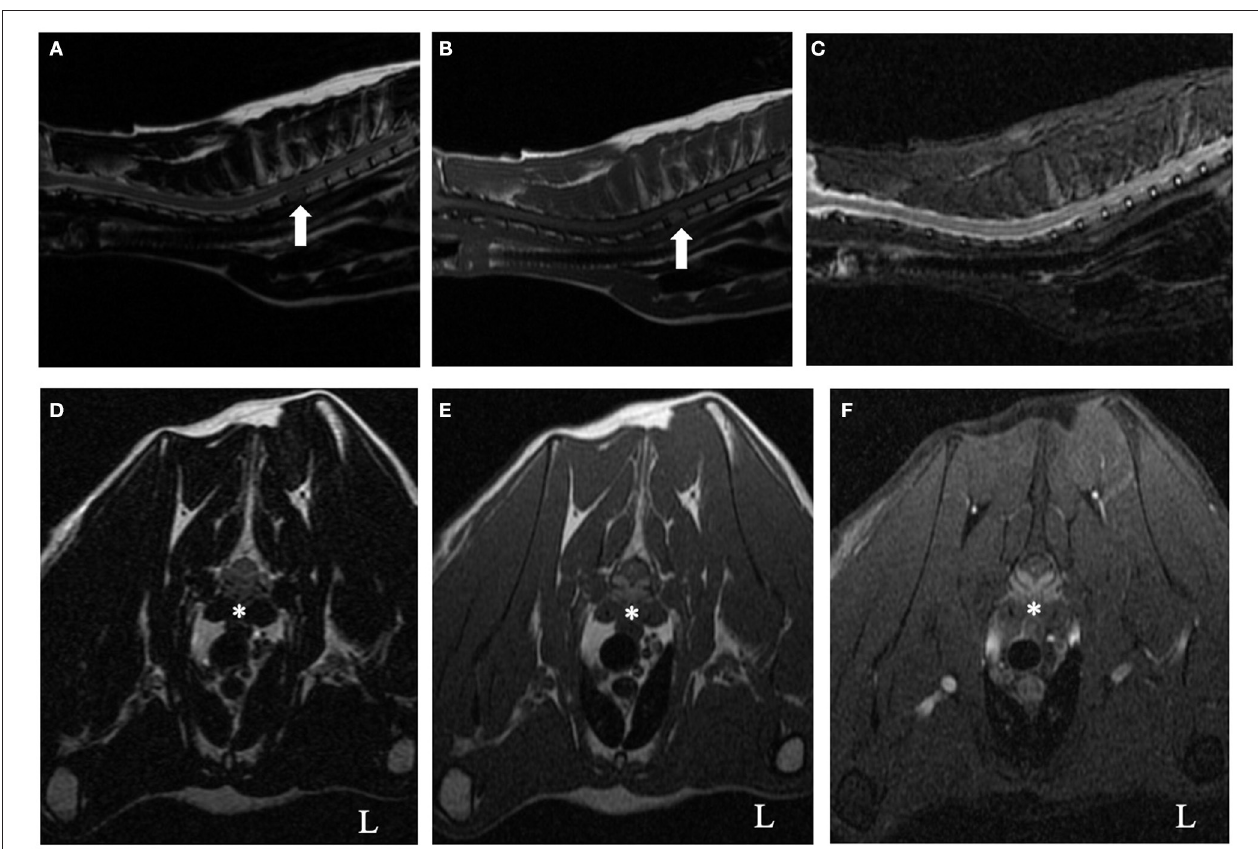
FIGURE 1 | T2-weighted (A,D) , T1-weighted (B,E) , short tau inversion recovery (STIR) (C) , and T1-weighted contrast fat saturation (F) cervicothoracic images of a 9-year-old cat. On the sagittal T2-weighted and T1-weighted images ( A and B , respectively), notice the homogenous reduction of signal intensity of the T2 vertebral body (arrow) relative to all other vertebrae. There was no abnormal hyperintense signal observed within the vertebral body on the STIR sagittal image (C) . At the level of mid-body of the T2 vertebra, there was a symmetric, ventrally located, extradural lesion causing secondary spinal cord compression (asterisk, D–F ). The lesion was isointense relative to spinal cord parenchyma on T2-weighted (D) and hyperintense on T1-weighted non-contrast images and T1-weighted contrast and fat saturation images ( E,F ,